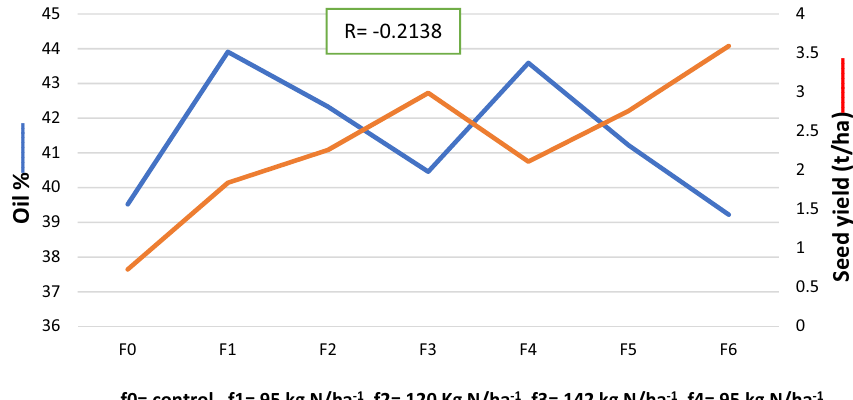
Figure 3. Correlation of Canola seed yield (t h −1 ) and oil % as affected by different nitrogen rates without and with yeast